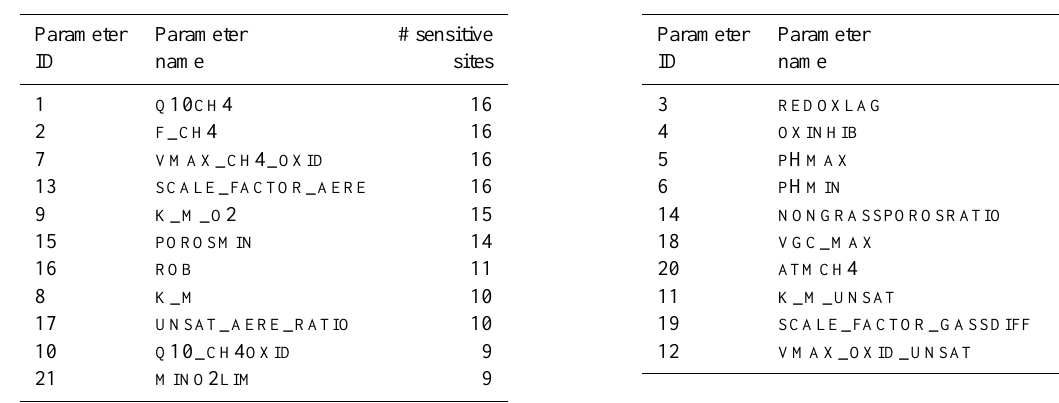
Table 3. Parameters that are least sensitive for observation sites (out of